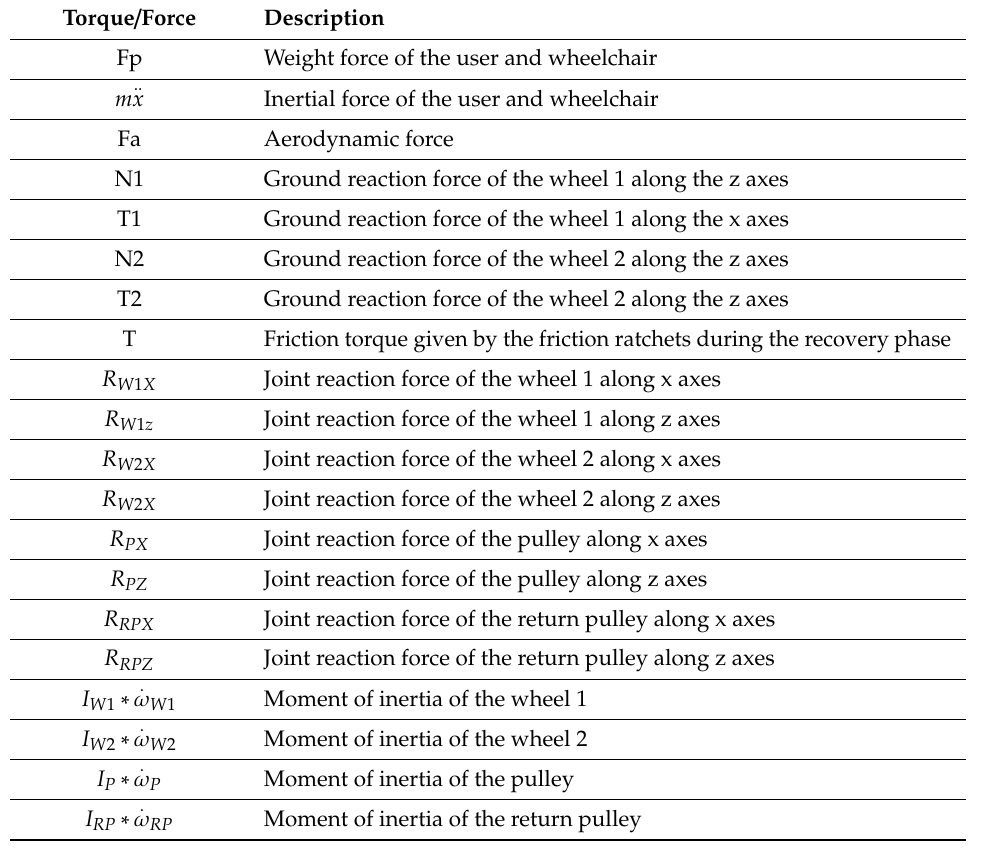
Table 3. Description of the torques and force of the dynamic model.